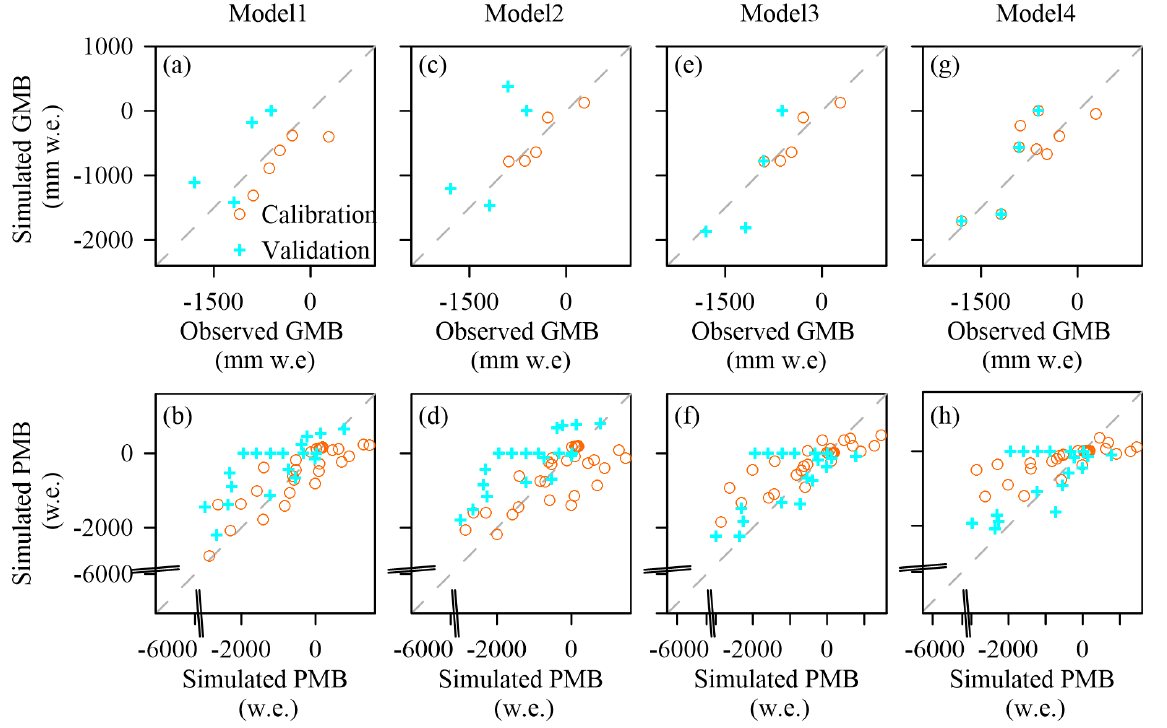
Figure 4. The modeled glacier mass loss and the stake measured mass loss as well as point mass loss of the Yala Glacier by the four sub-models. In the figure, the red circles are the data of calibration period and the blue crosses are the data of validation period; ( a , c , e , g ) are the simulated GMB (Glacier Mass Blalnce for the whole glacier) results of the four sub-models; ( b , d , f , h ) are the simulated PMB (Poin Mass Balance of the glacier).